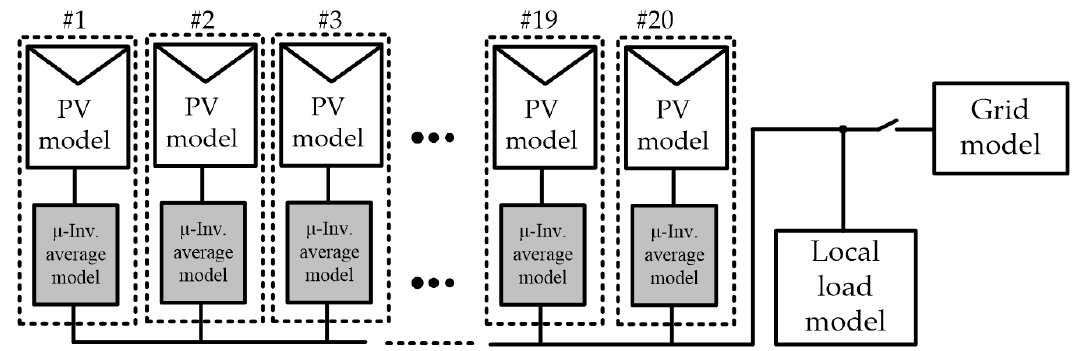
Figure 12. Simulation structure for aggregated microinverters.